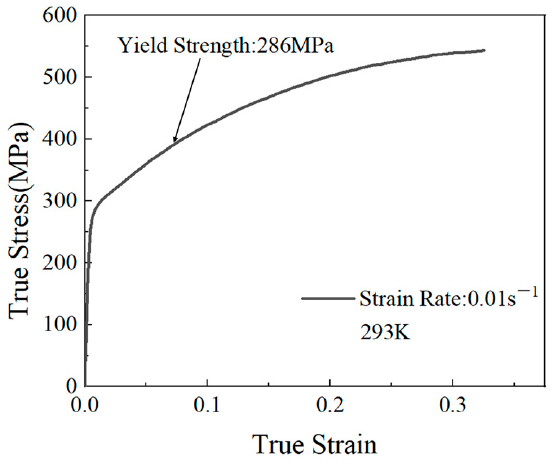
Figure 1. Stress-strain curve of 7050 aluminium alloy at a constant temperature of 293 K and a constant strain rate of 0.01 s − 1 .